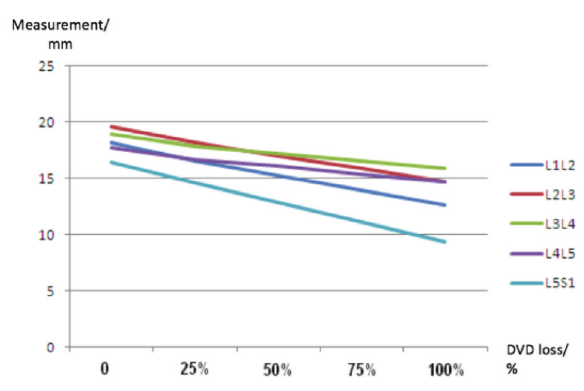
Predicted measurements of foraminal vertical height Fig. 3: with vertical disc diameter loss at every lumbar spinal